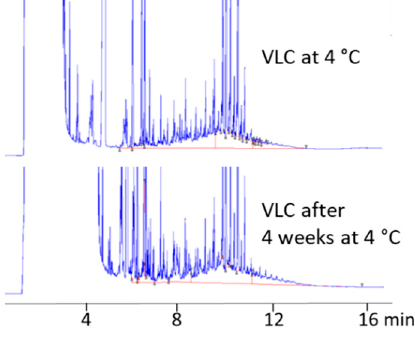
Figure 5. E ff ect of storage at 4 ◦ Figure 5. Effect of storage at 4 °C.